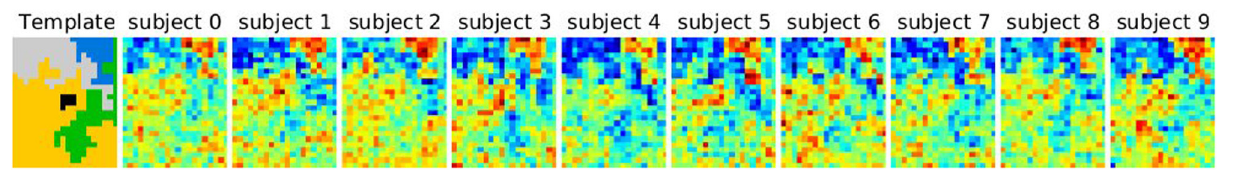
FIGURE 1 | Example of simulated data used in the 2D simulation experiment. The template or ground truth labeling is shown on the left side, and 10 individual datasets are sampled according to the model, jittered spatially by 2 pixels and then smoothed with a kernel of fwhm 1.17 pixels.